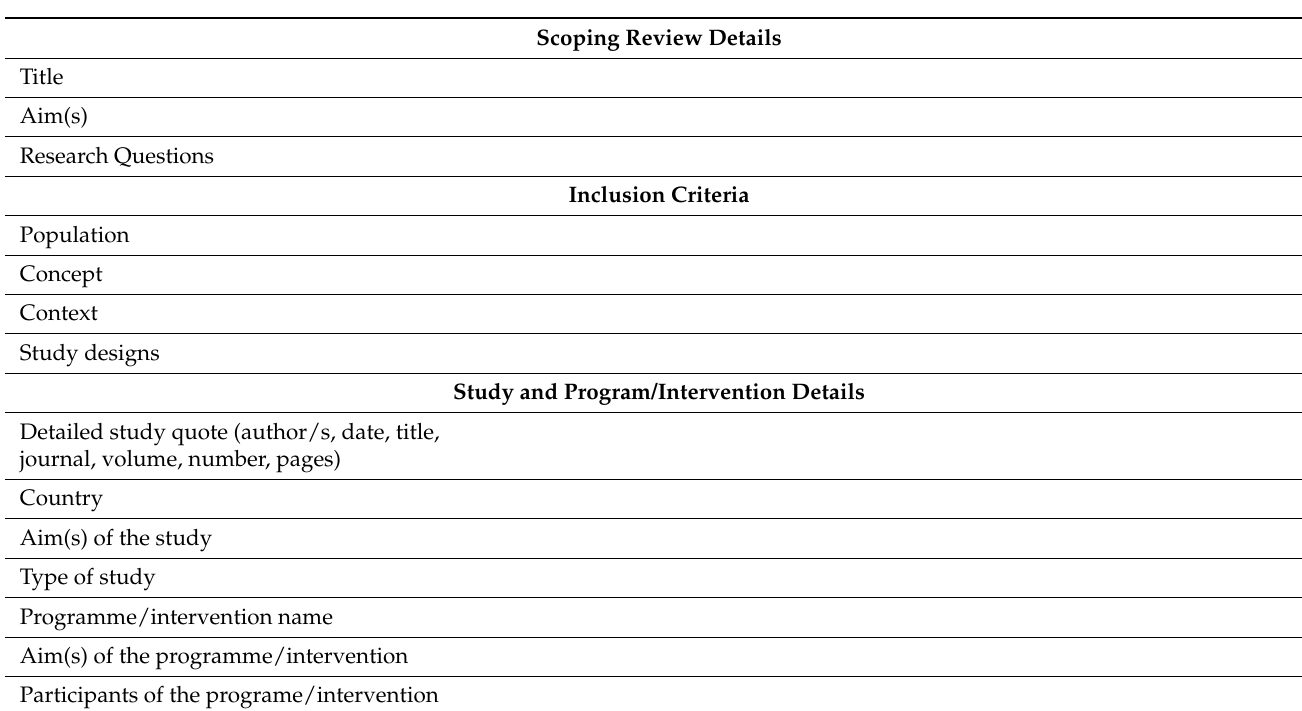
Table A1. Instrument for extracting data from the reviewed